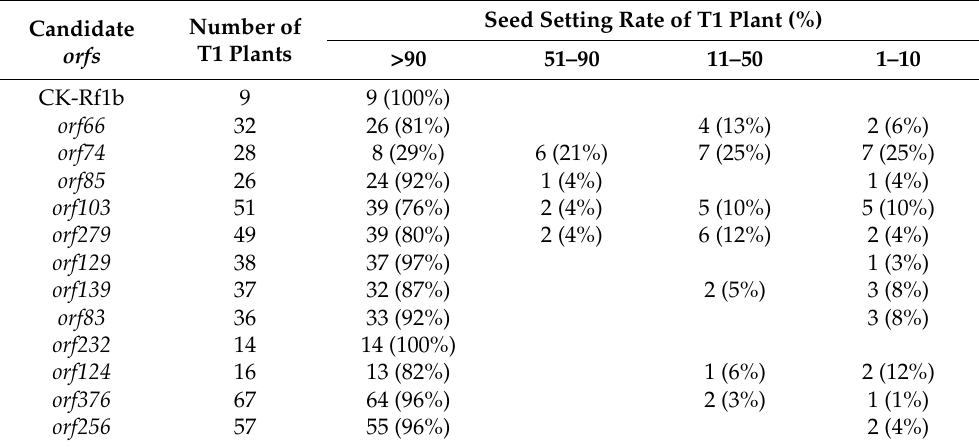
Table 6. Phenotypic study of transgenic Arabidopsis thaliana containing 315 bp mitochondrial signal peptide of Rf1b